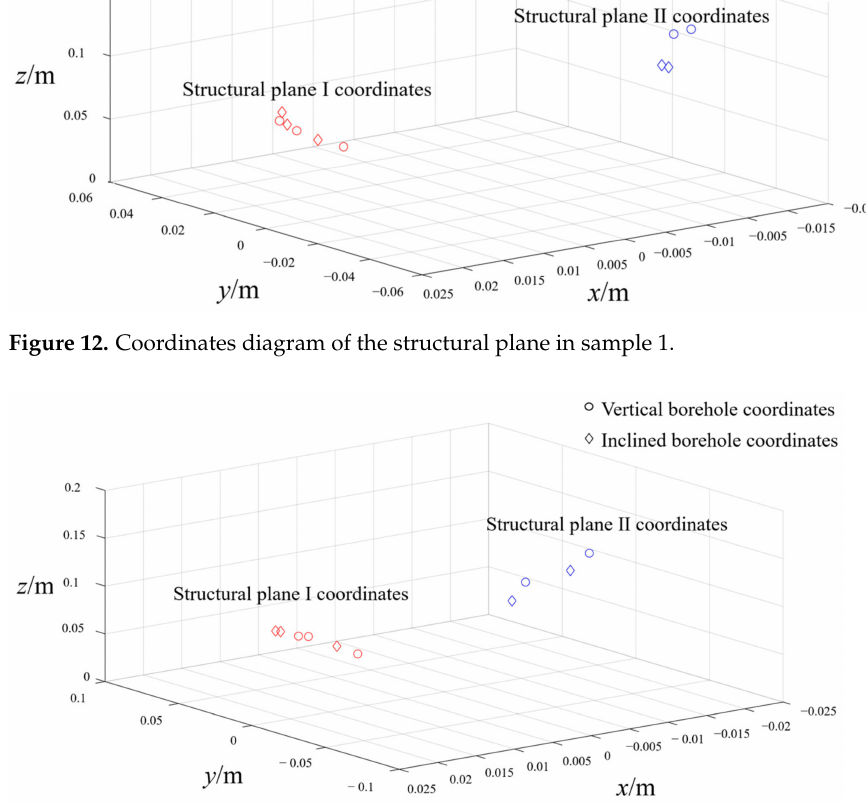
Figure 13. Coordinates diagram of the structural surface in sample